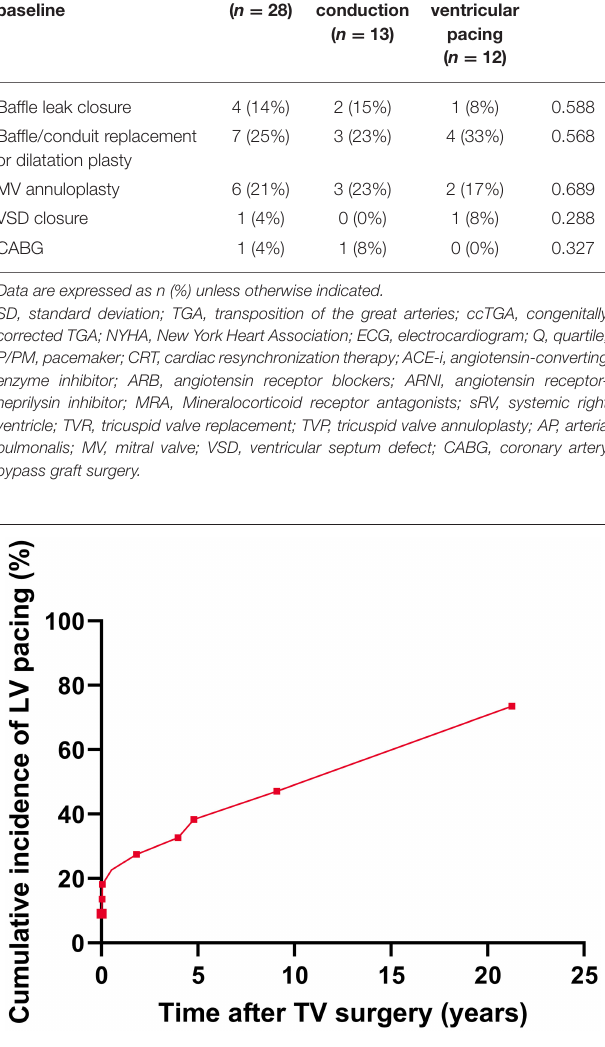
FIGURE 3 | Cumulative incidence curve for chronic LV pacing after TV